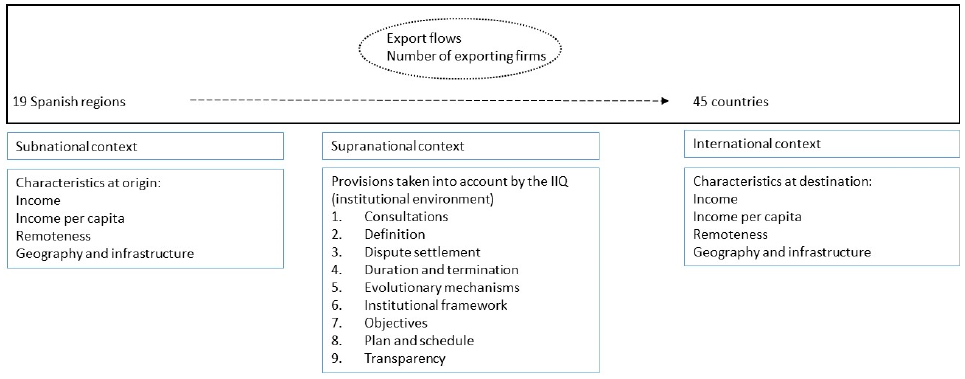
Figure 1: The role of institutional environment in international trade: subnational, supranational and international